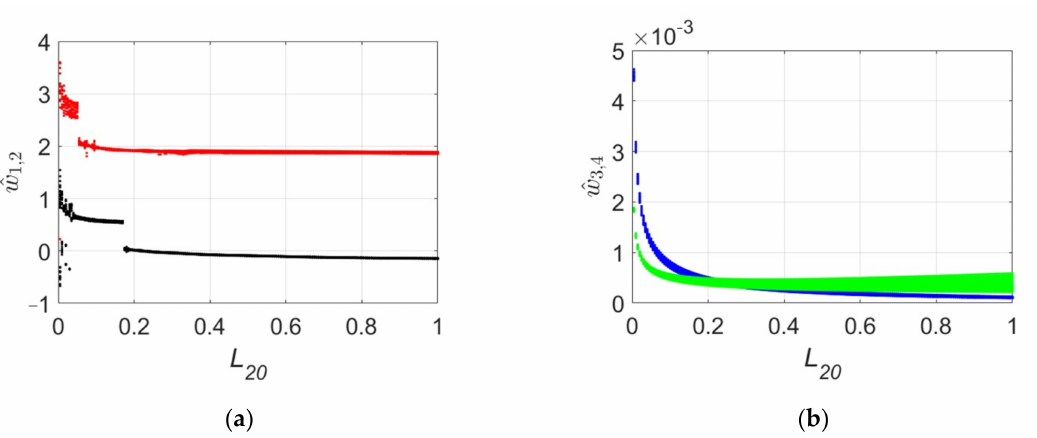
Figure 14. Bifurcation diagrams of the displacement and rotation responses for varying L 20 : ( a ) displacement; ( b ) rotation. Black and blue line are vertical, red and green line are horizontal.